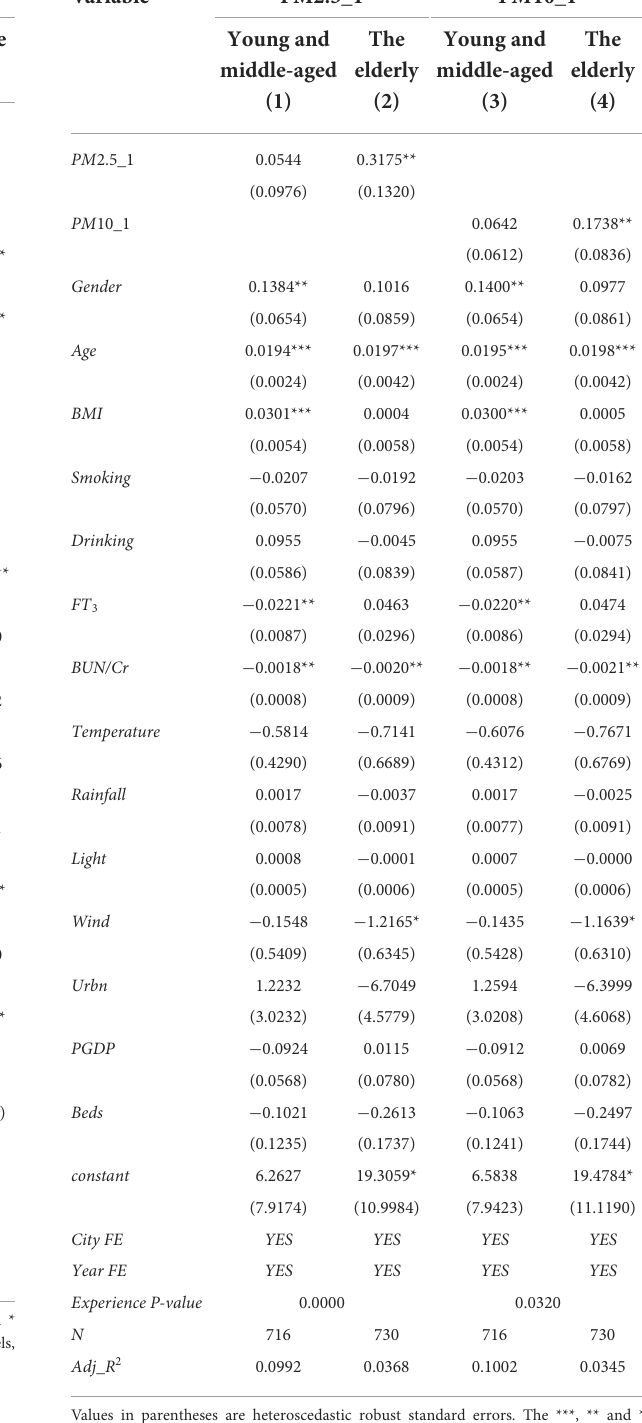
TABLE 5 Heterogeneity analysis of gender. TABLE 6 Heterogeneity analysis of